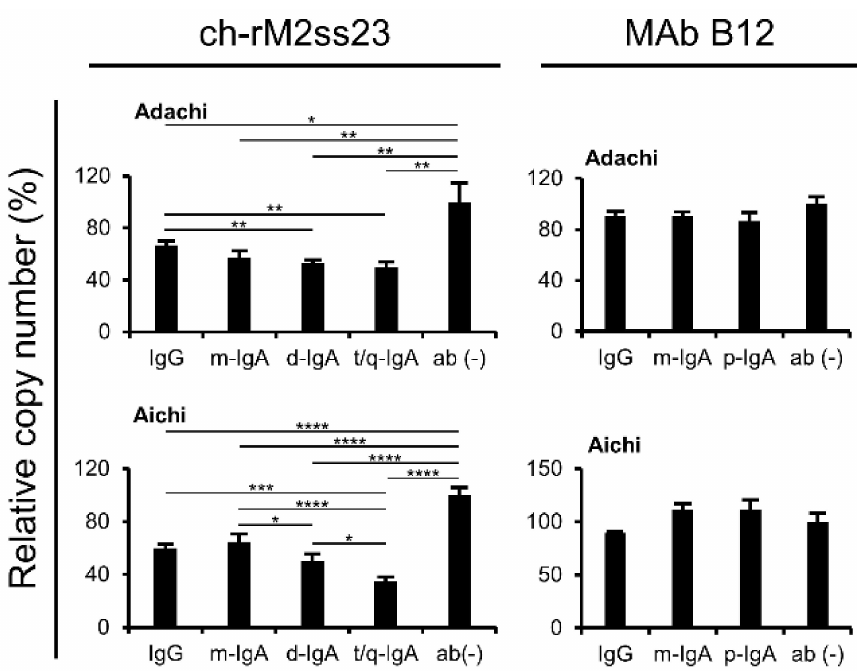
Figure 6. Detection of the viral RNA genome in the supernatants of IAV-infected cells. MDCK cells were infected with IAVs at m.o.i. 2.0 and incubated with or without MAb B12 and ch-rM2ss23 antibodies. The cells infected with Adachi and Aichi were incubated with or without the MAbs at 10 µ g / mL and 1 µ g / mL, respectively. The viral RNA genome was detected by real-time RT-PCR. The average copy number of the viral genome in the supernatant of IAV-infected cells incubated without MAbs was set to 100%. Each experiment was performed three times and the averages and standard deviations are shown. Asterisks indicate significant di ff erences (* p < 0.05, ** p < 0.01, *** p < 0.001, **** p < 0.0001) determined using one-way ANOVA followed by Tukey’s multiple comparison test.